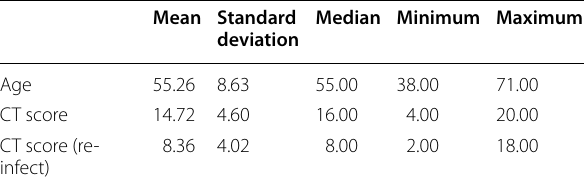
Table 2 The maximum, minimum, mean, median and standard deviation (SD) of the age, initial CT score and re-infection CT